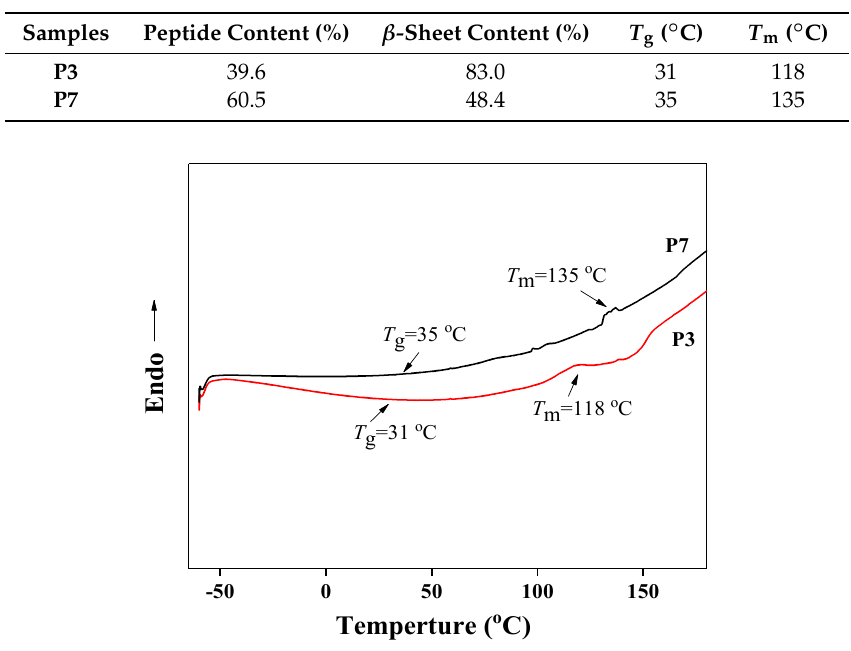
Figure 2. Fourier transform infrared (FTIR) spectra of P3 and P7 .